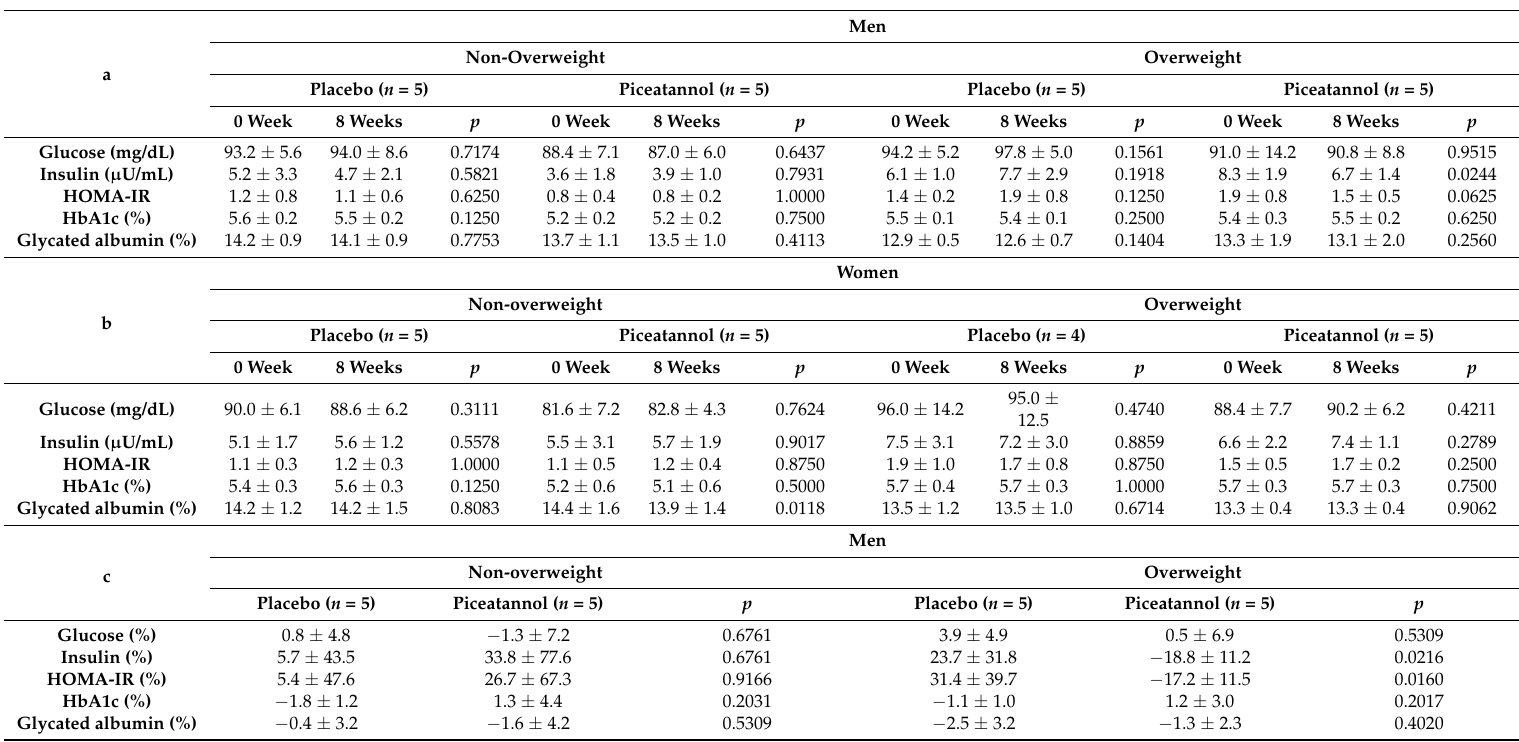
Table 3. Glucose metabolism-related data, including fasting glucose, insulin, homeostasis model assessment–insulin resistance (HOMA-IR), HbA1c and glycated albumin at baseline and 8 weeks after placebo or piceatannol supplementation (a: men, b: women). c: change rate of fasting glucose, insulin, HOMA-IR, HbA1c and glycated albumin for 8 weeks of placebo or piceatannol